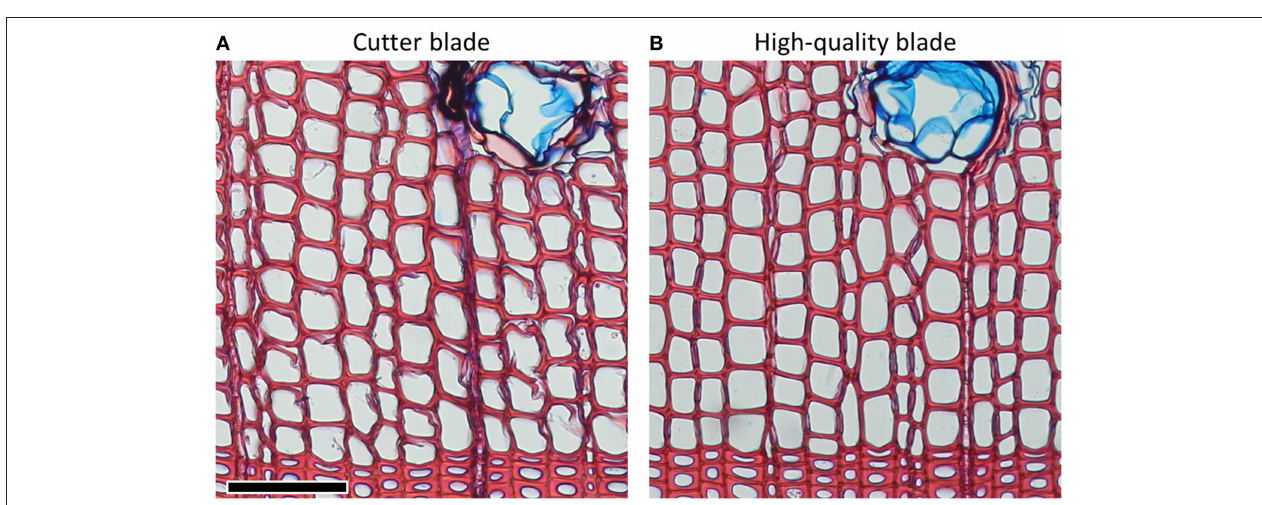
FIGURE 2 | Pinus sylvestris cross-sections of 15 µ m thicknesses from the same wood piece cut with (A) cutter and (B) high-quality blades. Problems with disrupted cell structures can often be significantly reduced by using high-quality blades. Scale bar = 100 µ m.